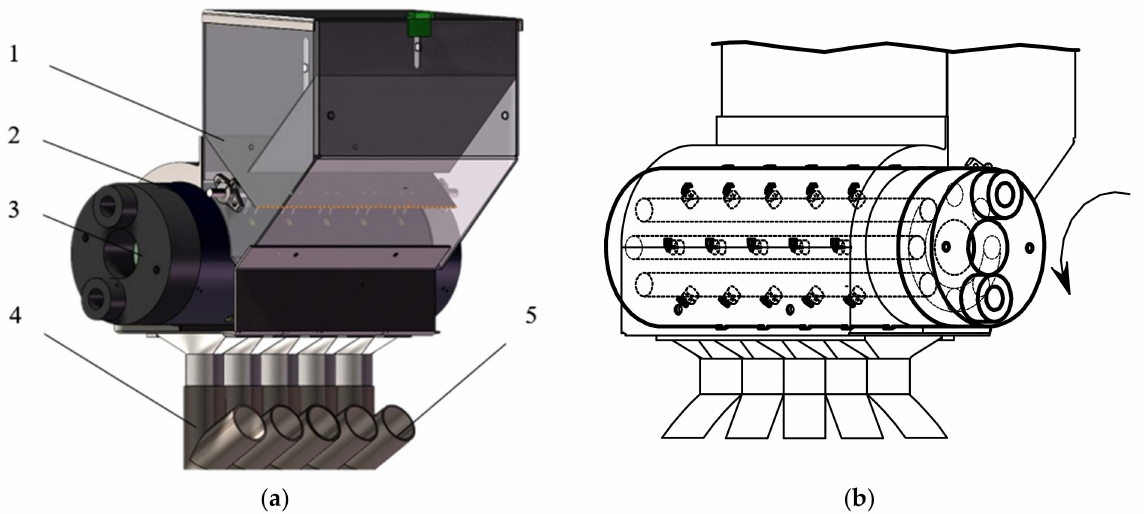
Figure 1. ( a ) Main structure of rice metering device. 1. seed box 2. outer cylinder 3. ventilation shell 4. seeding tubes 5. air delivery ports; ( b ) Schematic diagram of seeding process by vacuum centralized cylinder metering device.